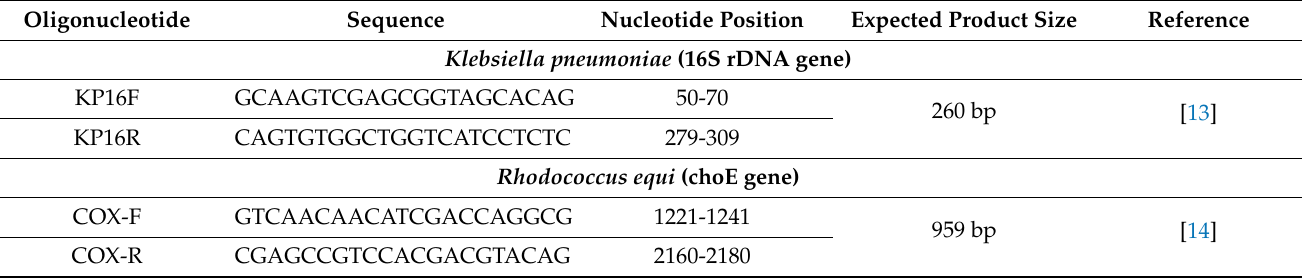
Table 1. The sequences, nucleotide positions and expected product size of primers designed to amplify specific partial sequences of targeted genes of K. pneumoniae subsp. pneumoniae and R. equi .